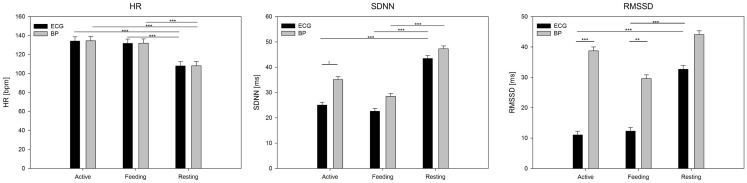
Mean values (±SE) of HR, SDNN, and RMSSD derived from ECG and BP during active behavior, feeding, and resting. Calculation was based on 5 min segments per behavior and averaged over individuals. Significance is given as follows: ***P < 0.001; **P < 0.01; *P < 0.05; and †P < 0.1.